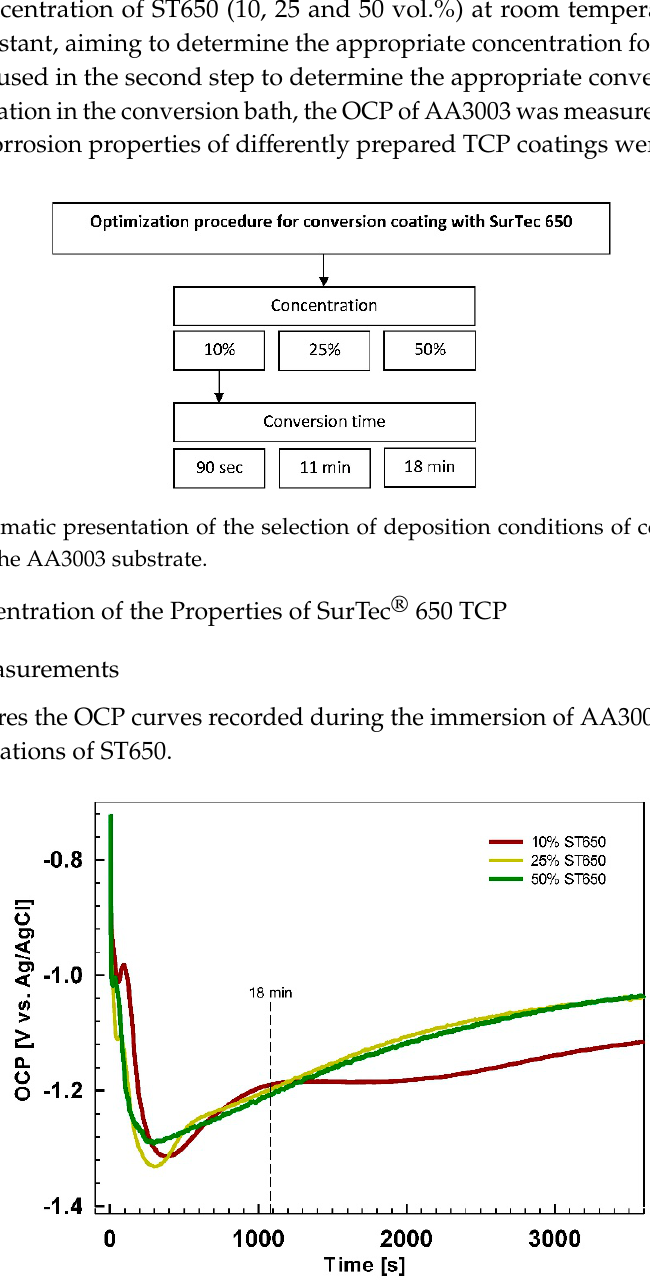
Figure 5. The dependence of the open circuit potential vs. time during the immersion of AA3003 in 10%, 25% and 50 vol.% SurTec 650 conversion bath at room temperature.